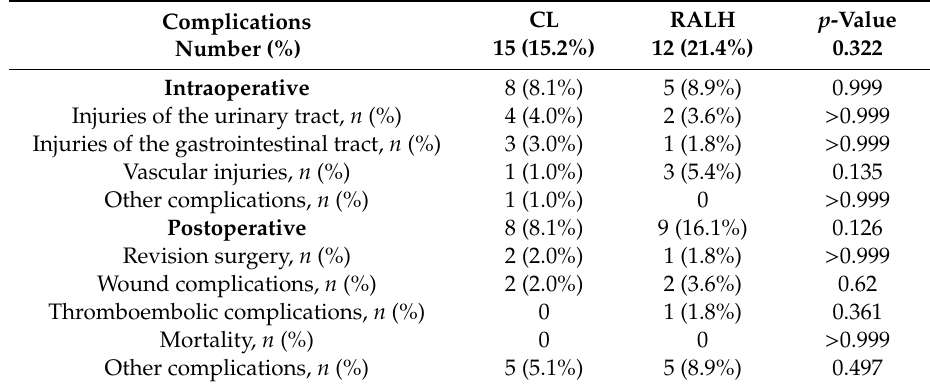
Table 2. Intraoperative and postoperative